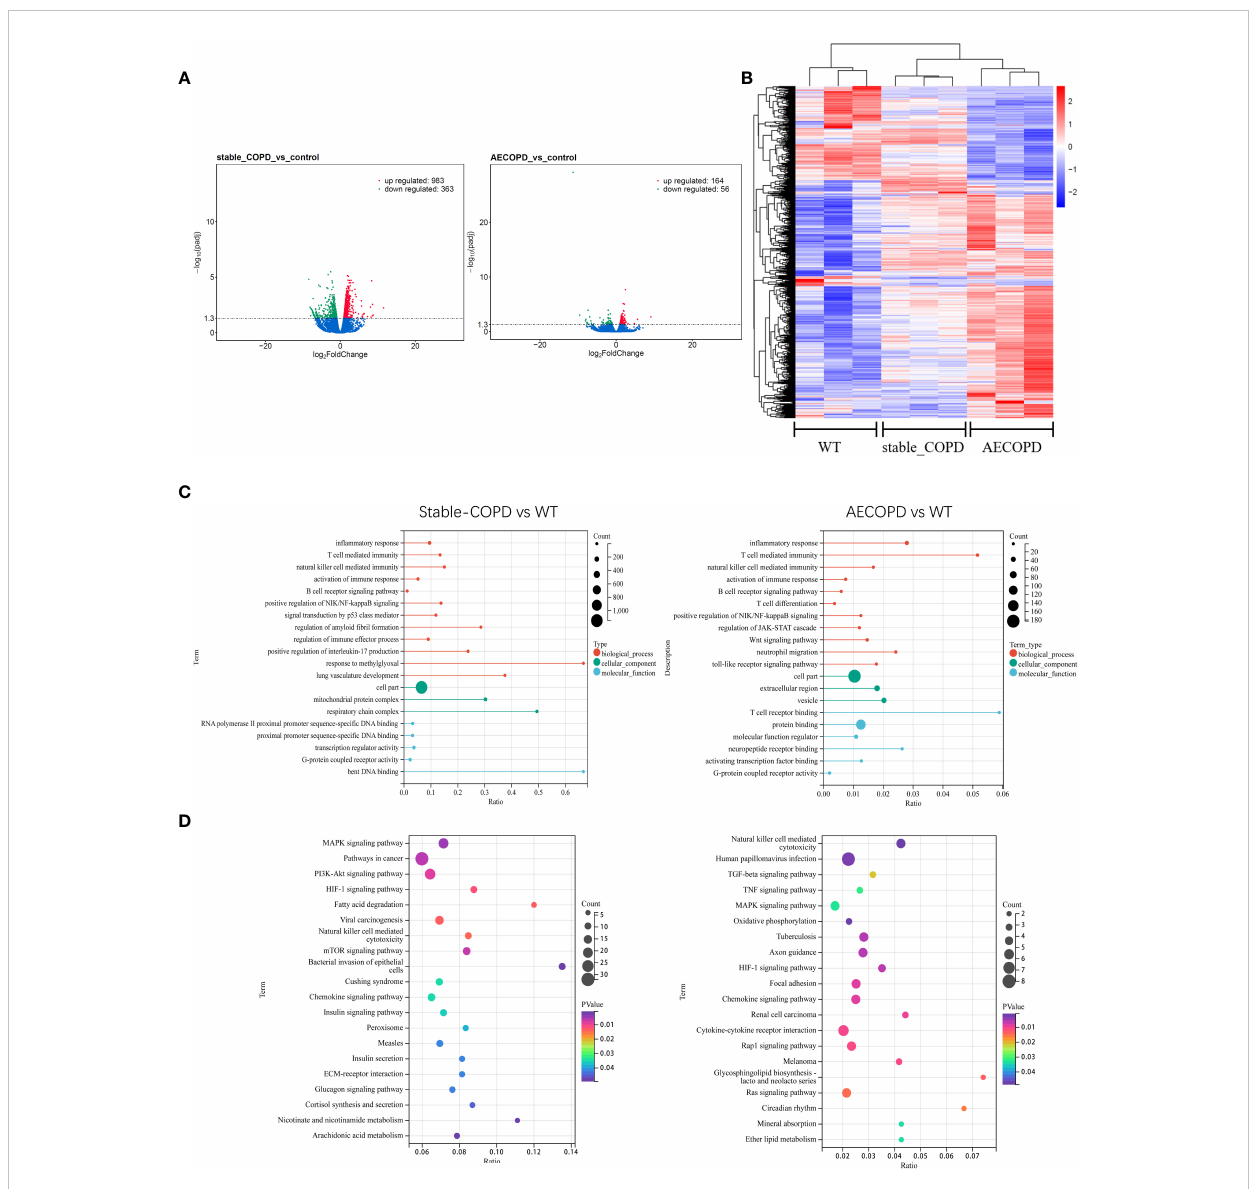
FIGURE 7 DEGs during the occurrence and development of COPD: (A, B) Volcano map and thermal map show DEGs in lung tissues (|log2FC |>1, P < 0.05). (C) GO enrichment analysis of DEGs. (D) KEGG enrichment analysis of